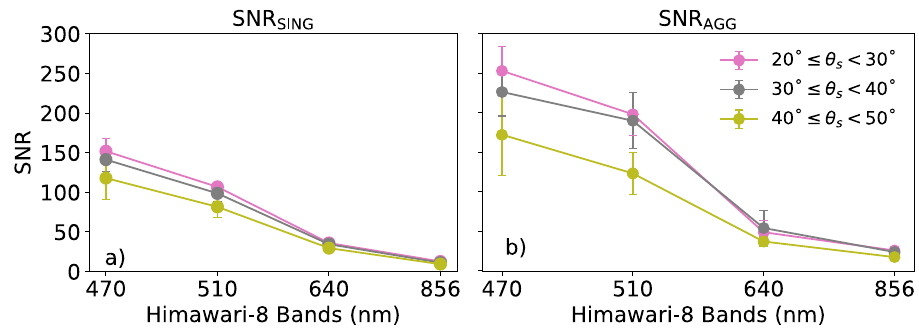
Figure 10. Spectral distribution of signal-to-noise ratios calculated for single ( SNR SING ) ( a ) and aggregated observations ( SNR AGG ) ( b ), and grouped for three ranges of θ s . Error bars were computed as standard deviations of SNR within each group of θ s .